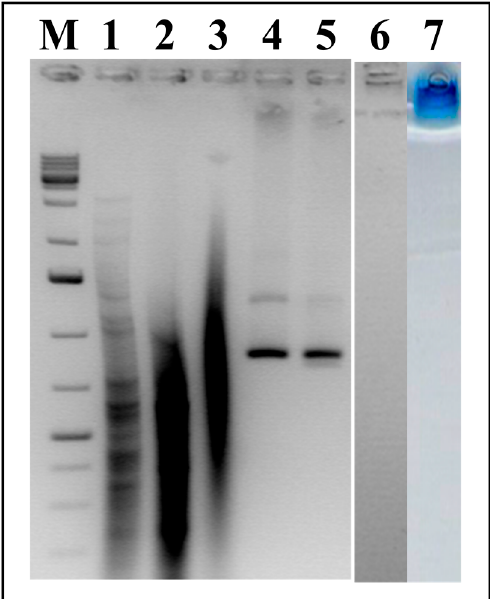
Figure 8. Extraction of RNA from HBc/D VLPs; NAGE in 2% Agarose. M —GeneRuller 1 kb DNA Ladder (SM1331, Thermo Scientific™, Vilnius, Lithuania); 1 —dsRNA used for packaging; 2 —RNA extracted from packaged HBc/D VLPs; 3 —RNA extracted from native HBc/D VLPs; 4 —native HBc/D VLPs; 5 —HBc/D VLPs packaged with dsRNA; 6 , 7 —empty HBc/D VLPs; M and 1 – 6 —stained with EtBr; 7 —stained with Coomassie Brilliant Blue R250. Note: different amounts of VLPs were loaded into tracks 4 and 6 , not corresponding to the amounts of VLPs used for the extraction of RNA (tracks 2 and 3 ).